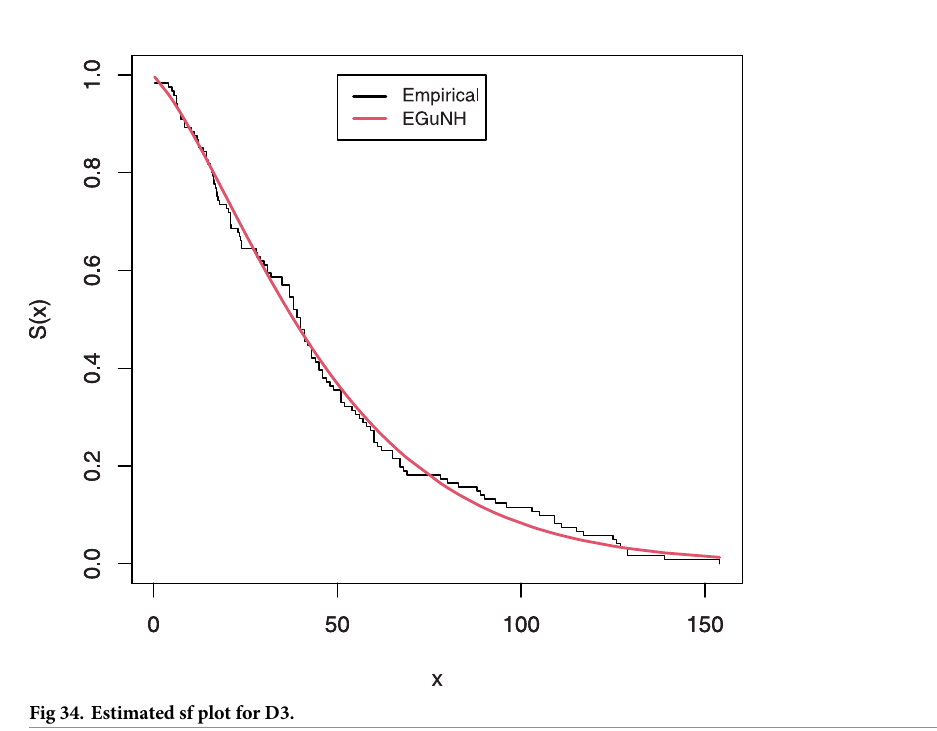
Fig 34. Estimated sf plot for